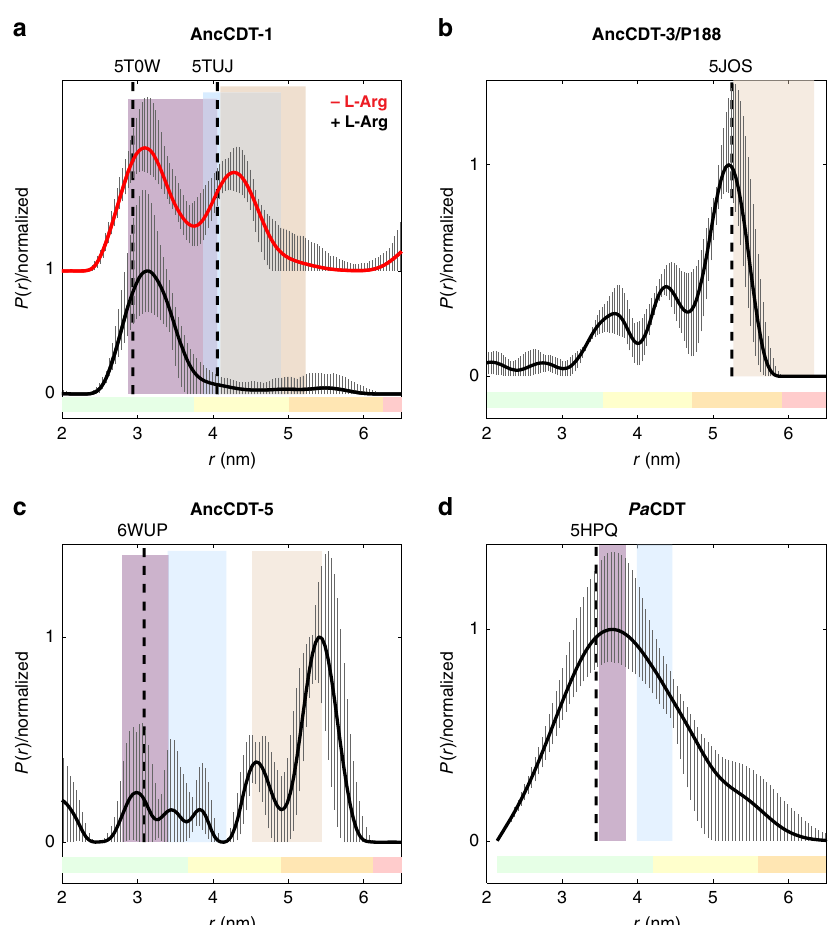
Fig. 3 Solution dynamics of AncCDT-1, AncCDT-3/P188, AncCDT-5 and P a CDT probed by DEER. Gd(III) – Gd(III) distance distributions for samples of propargyl-DO3A-Gd(III)-tagged a refolded AncCDT-1 (-/ + L-Arg, tagged at positions 68 and 138), b natively puri fi ed AncCDT-3/P188 (tagged at positions 68 and 138), c natively puri fi ed AncCDT-5 (tagged at positions 68 and 138) and d natively puri fi ed Pa CDT (tagged at positions 68 and 139 and diluted by a factor of 10 using unlabelled Pa CDT). Distance distributions were obtained using DeerAnalysis 77 ; the solid lines represent the distributions with the best r.m.s.d. from the experimental data, and the striped regions represent the variation of alternative distributions (± 2 times the standard deviation) obtained by varying the parameters of the background correction and noise. The coloured bars at the bottom of each panel re fl ect the reliability of each region of the distribution, corresponding to the DEER evolution time used, as de fi ned in DeerAnalysis (pale green: the shape of the distance distribution is reliable; pale yellow: the mean distance and distribution width are reliable; pale orange: the mean distance is reliable; pale red: long-range distance contributions may be detectable, but cannot be quanti fi ed.). The original DEER data and DEER form factor traces are shown in Supplementary Figs. 5, 7 and 8. Vertical dashed lines represent the Gd(III) – Gd(III) distances estimated by modelling propargyl-DO3A-Gd(III) tags onto the crystal structures of each protein. The shaded areas represent the range of calculated Gd(III) – Gd(III) distances when propargyl-DO3A-Gd(III) tags are modelled onto a number of individual MD snapshots representing the closed (magenta), open (blue) and wide-open (orange)